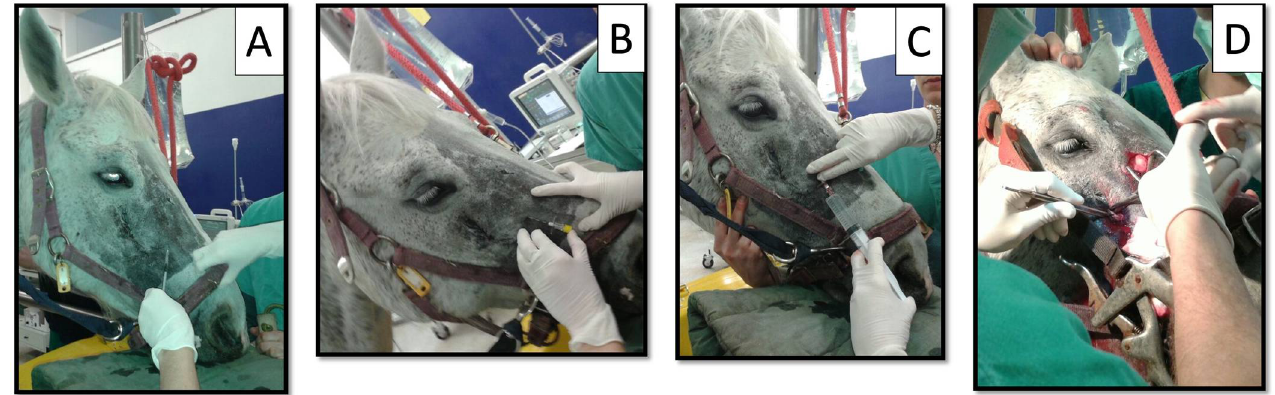
Figure 2. March 2014: a 17-year-old mare in group STA undergoing maxillary sinus trephination and dental root curettage. Horse was restrained in a stock, sedated and with the head sustained by a headrest. Subcutaneous injection of 1–2 mL 2% lidocaine at the infraorbital foramen ( A ); sliding of a 20 G × 5 cm Tuohy needle into the infraorbital canal with the bevel oriented laterally ( B ); injection of 10 mL local anesthetic after withdrawn of the stylet and needle aspiration to exclude any vessel puncture ( C ); surgical procedure ( D ).